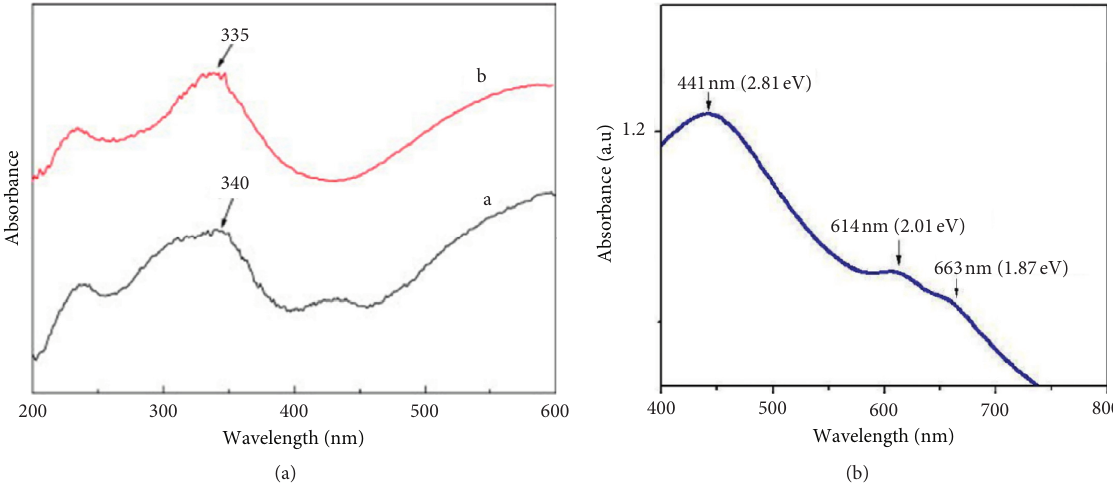
Figure 3: (a) Representative of UV/Vis of bulk MoS 2 and MoS 2 nanosheets [59] and the UV/vis (b) showing band gaps